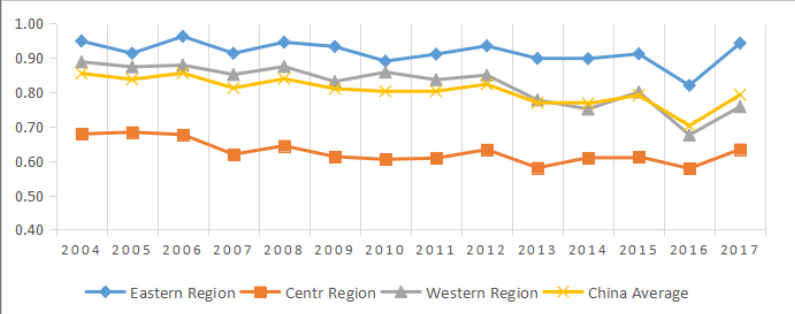
Figure 2. Trends in eco-efficiency of agricultural land in China and regions from 2004–2017.